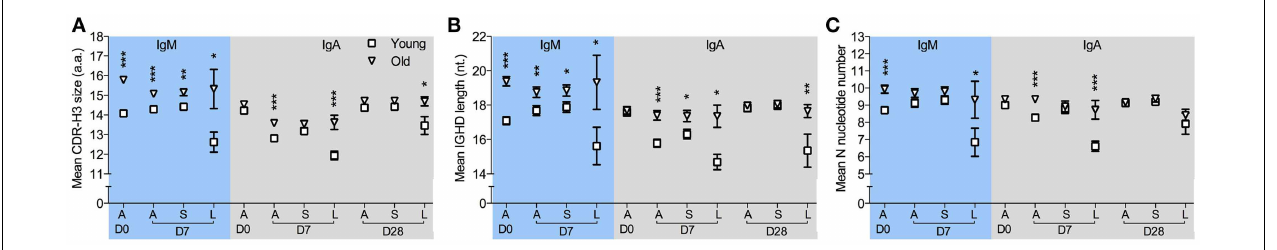
(B) the mean length of overall IGHD genes (in nucleotides), and (C) the mean number of N-nucleotides from all clonotypes (A) , clonotypes ≤ 4 (S) and clonotypes ≥ 5 in size (L) were compared between six young (square) and six old (triangle) donors at D0, D7, and D28, using Mann–Whitney U- tests (* p < 0.05, ** p < 0.005, and *** p < 0.0005). Error bars indicate ±